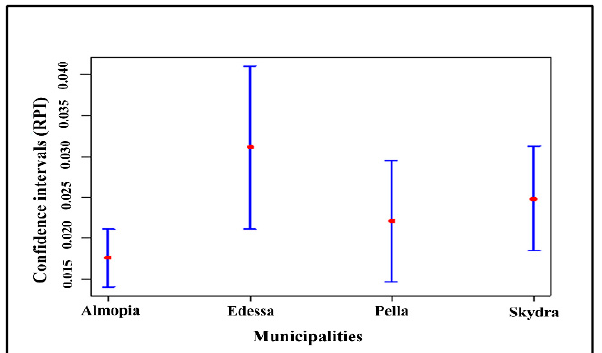
Figure 4. The 95% confidence intervals of RPIA.